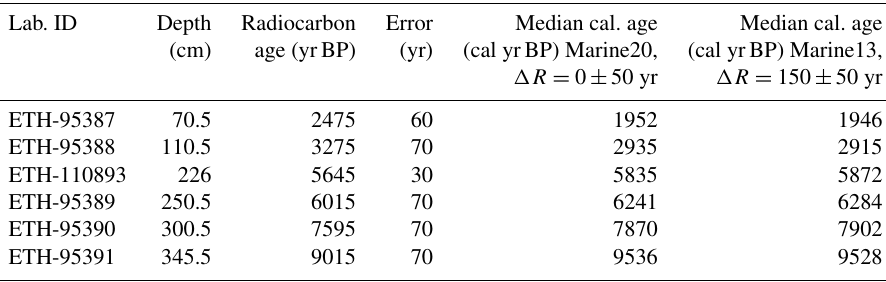
Table A1. Comparison of radiocarbon dates calibrated with the Marine20 (Heaton et al., 2020) and the Marine13 (Reimer et al., 2013) calibration curve in core DA17-NG-ST07-73G. For the dates calibrated with the Marine20 we used a local marine reservoir age correction ( (cid:49)R ) of 0 ± 50 years; for the dates calibrated with the Marine13 we used a (cid:49)R of 150 ± 50 years, as this is the approximate offset between the two curves (Heaton et al.,